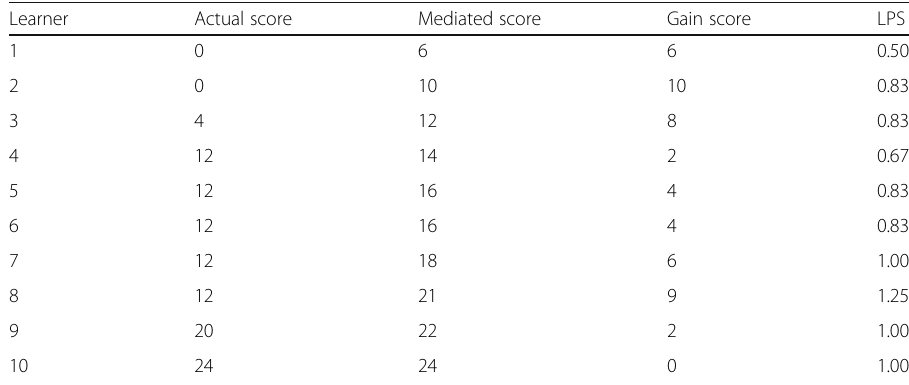
Table 2 Some learners ’ scores in the learner profile